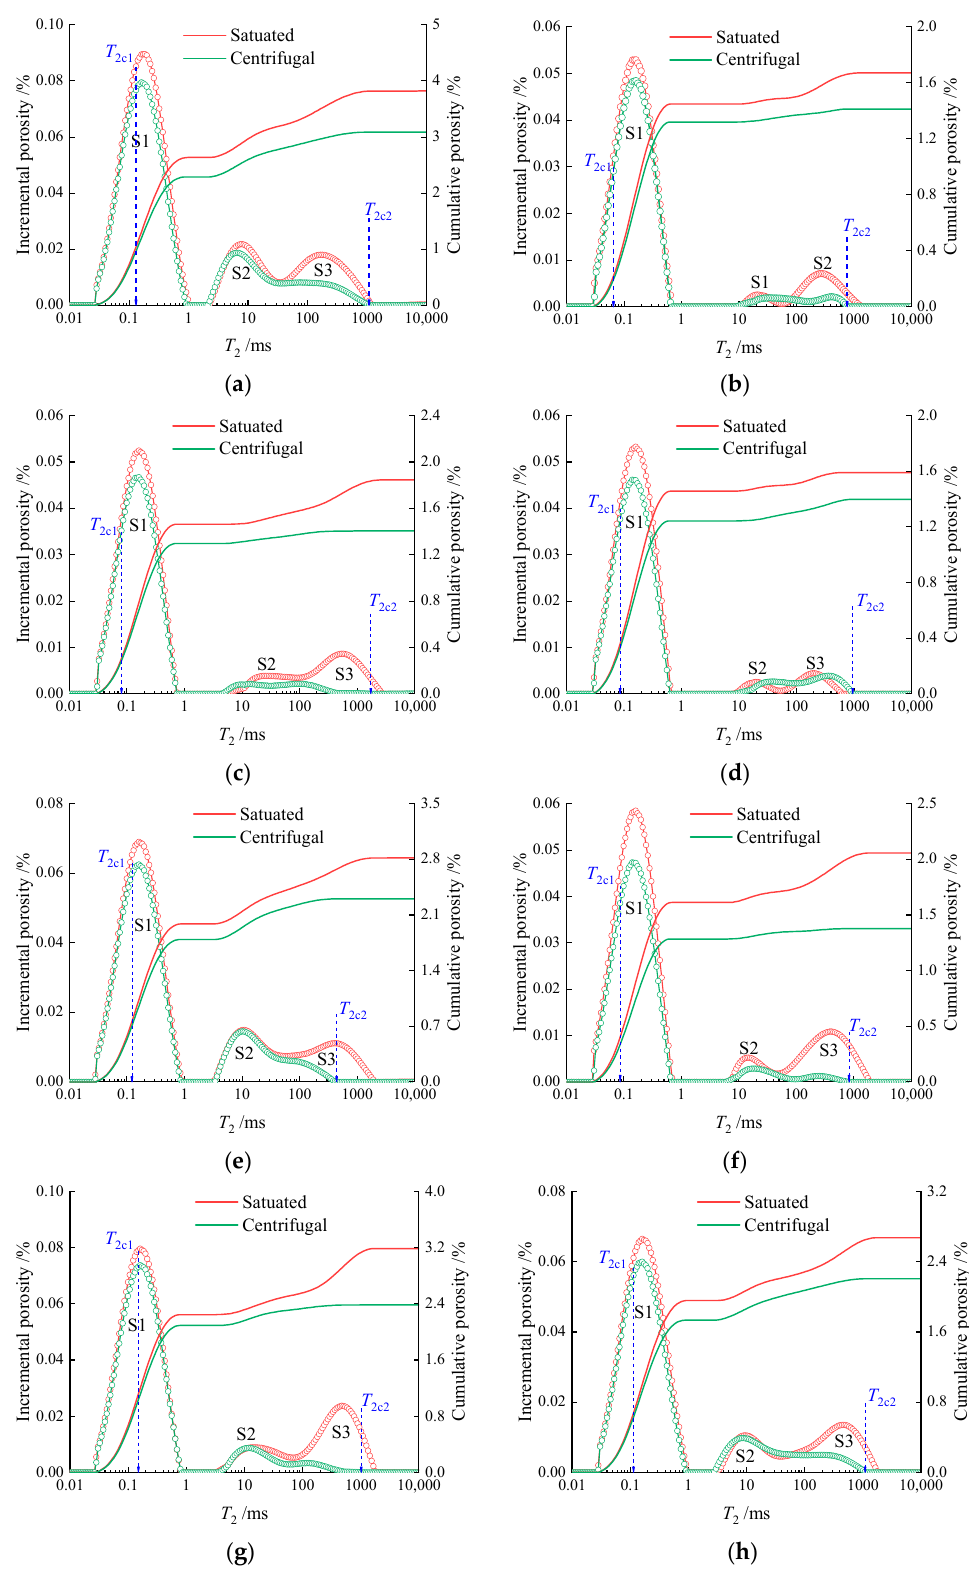
Figure 7. NMR T 2 spectrum and cumulative porosity curve of coal before and after centrifugation: ( a ) sample A; ( b ) sample B; ( c ) sample C; ( d ) sample D; ( e ) sample E; ( f ) sample F; ( g ) sample G; ( h ) sample H.